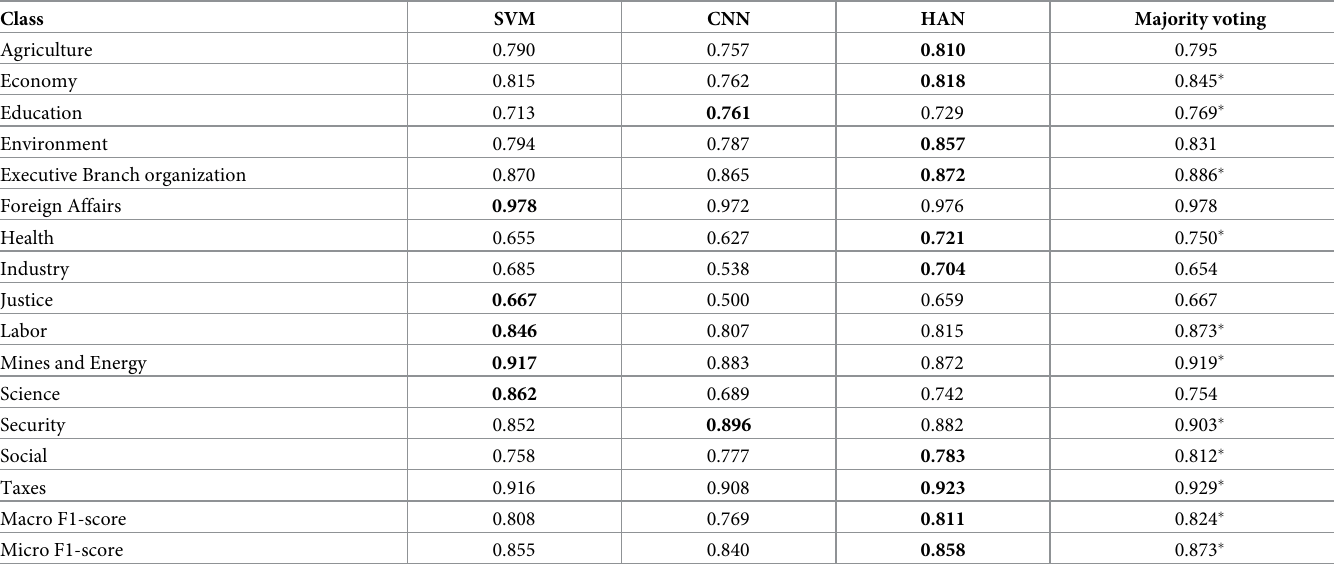
Table 6. F1-score for the Senate-based taxonomy